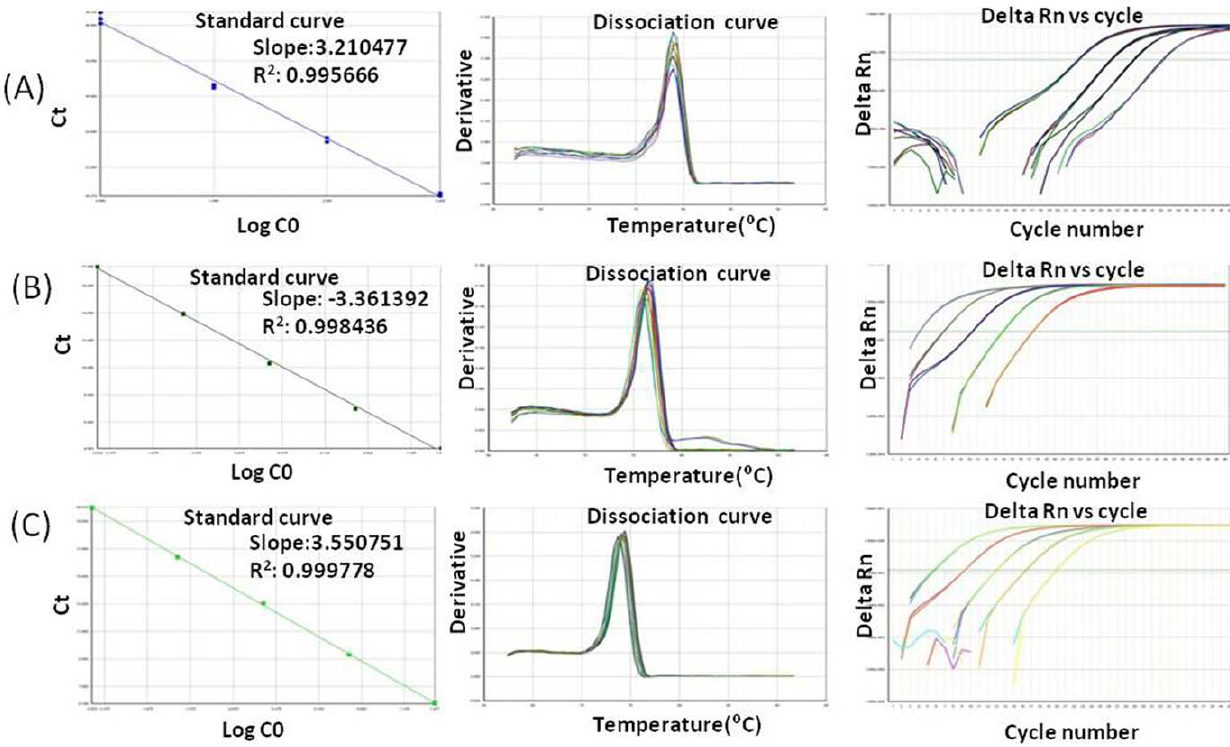
Figure 3. Representative standard and dissociation curves and amplification plots from Real Time PCR assays. Melting (dissociation) curve showing a single peak corresponds to a single amplicon. ( A ) Representative curves for GAPDH , ( B ) RS3 and ( C ) RS5.